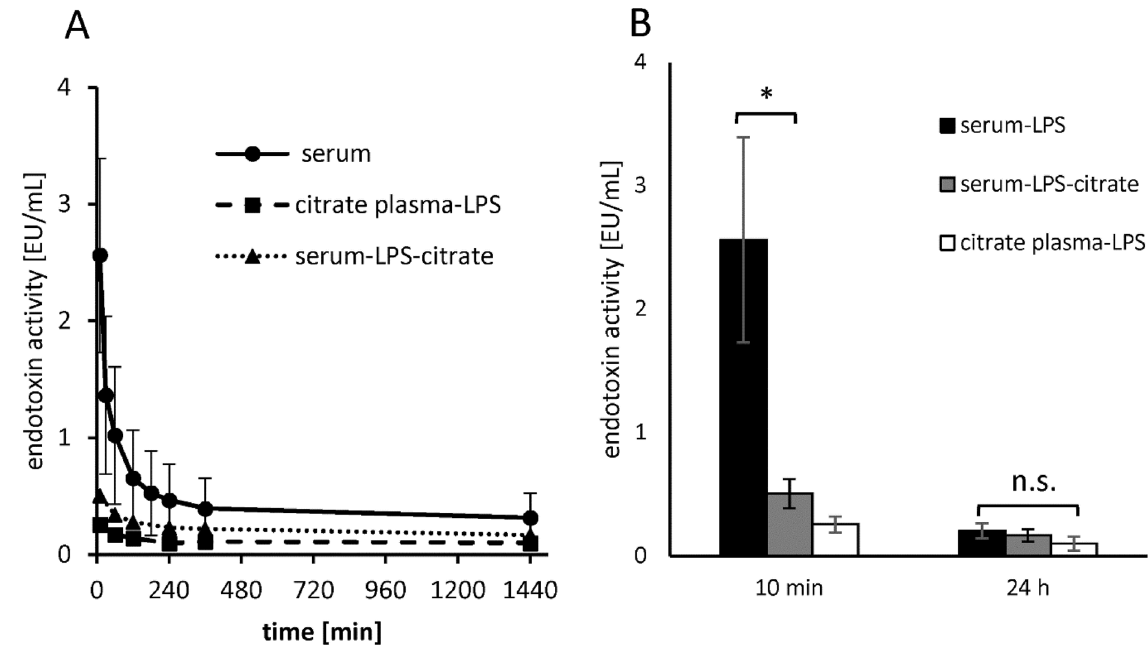
Figure 9. Influence of citrate anticoagulation on endotoxin activity in human plasma. To check whether the time-dependent endotoxin neutralization of 5 ng/mL LPS ( E.coli ) is influenced by citrate anticoagulation, LPS was incubated in different plasma and serum samples for 24 h (reverse mode) and the endotoxin recovery was measured by LAL test ( A ). The kinetic LPS neutralization was tested in citrate plasma (citrate plasma-LPS), in serum and in serum where citrate was added after the incubation period immediately before LAL analysis (serum-LPS-citrate). The bars marked with * indicate from which incubation time of LPS a significant (p ≤ 0.05) endotoxin reduction is achieved compared to the 10 min sample ( B ). n.s. not significant. Mean ± standard deviation of three independent experiments with plasma/serum from different donors are shown.